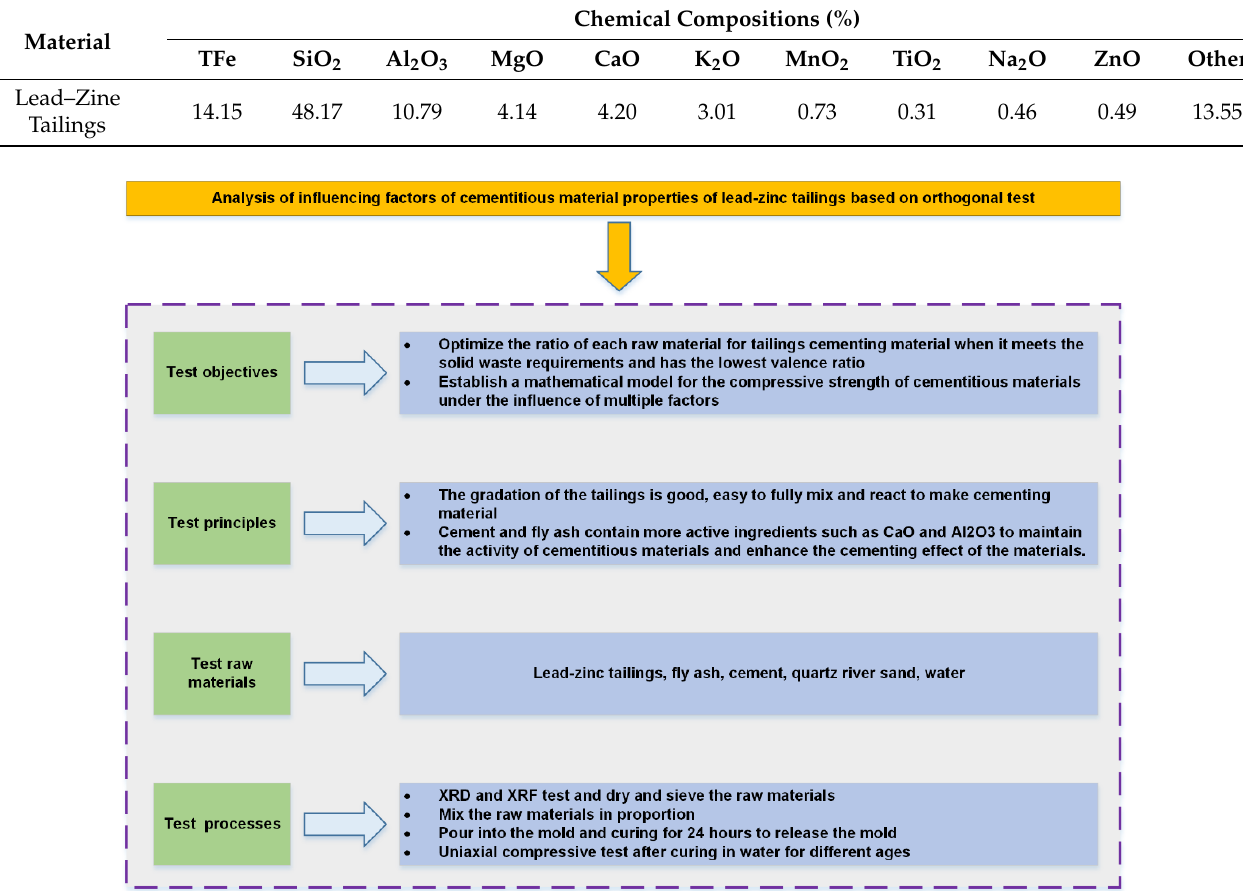
Figure 3. Test Design. Figure 3. Test Table 3. Mix proportions of experiment.